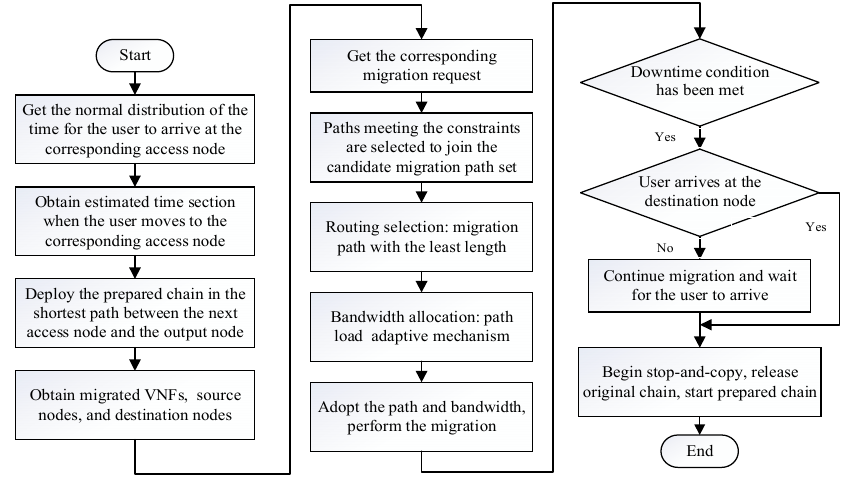
Figure 6. Migration algorithm of overall process. Algorithm 1. Migration algorithm of overall process